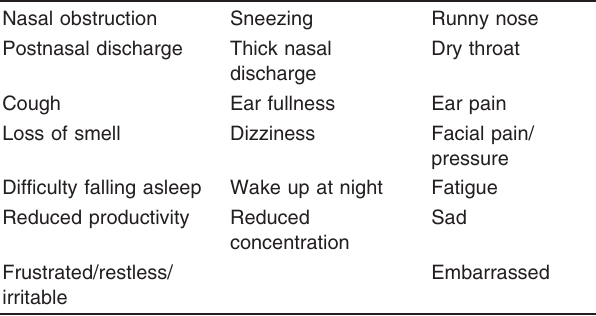
Table 1 Items of sinonasal outcome test − 20 German adapted version and NOSE